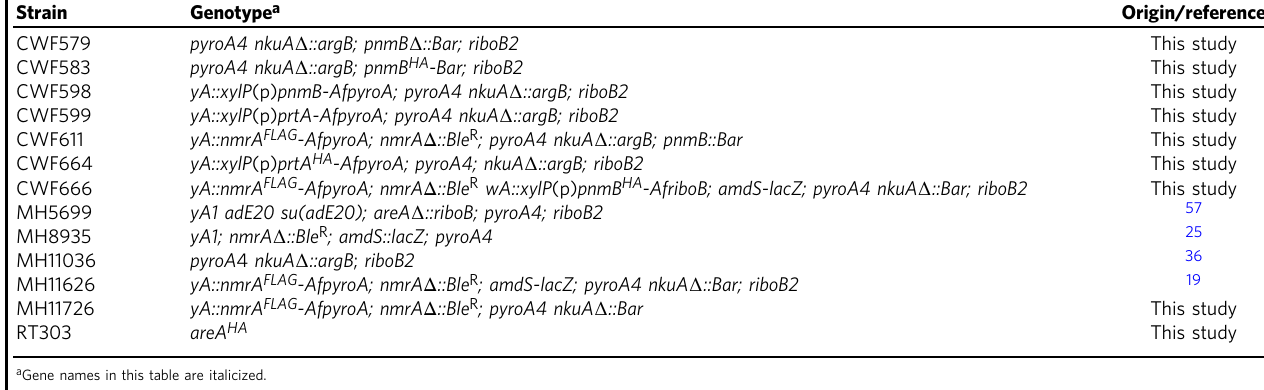
Table 2 A. nidulans strains used in this study.